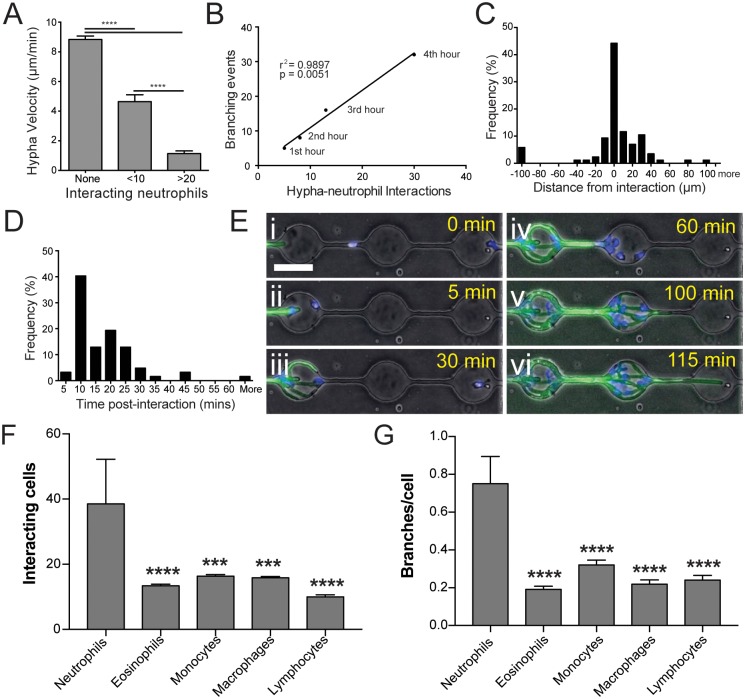
Interaction with neutrophils induces hyphal branching.(A) Amplitude of neutrophil response correlates to reduction in velocity of hyphal growth, with larger numbers of neutrophils better able to slow growth. N ≥ 10 measurements from n ≥ 5 representative hyphae per group. (B) Induction of branching over time shows a linear correlation with number of neutrophil interactions. (C) Induction of new branches is enriched proximally to neutrophil interactions, with most branches occurring within 20–30 μm of an interaction point. (D) Following interaction, most branches are induced within 5–25 minutes post interaction. (E) Robust recruitment of neutrophils amplifies branch induction (iii-v, S2 Movie) and slows hyphal growth. However, at least one hypha branch is usually able to avoid confrontation and continue growing unobstructed (vi). (F) Neutrophils are recruited to fungal hyphae in significantly higher numbers than other immune cells. (G) Neutrophil interaction with hyphae induces apical branching at more than twice the rate of other immune cells. N ≥ 24 hyphae scored from N ≥ 4 experiments. Error bars: mean ± SEM. Statistics: one-way ANOVA with Tukey’s post test. Adjusted p values: *p≤0.05, **p≤0.01, ***p≤0.001, ****p≤0.0001.